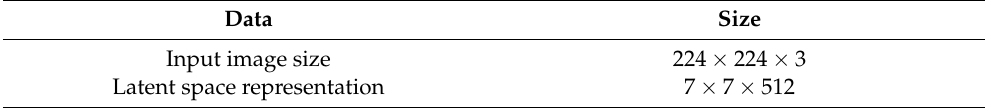
Table 3. Dimensionality Reduction of the Input